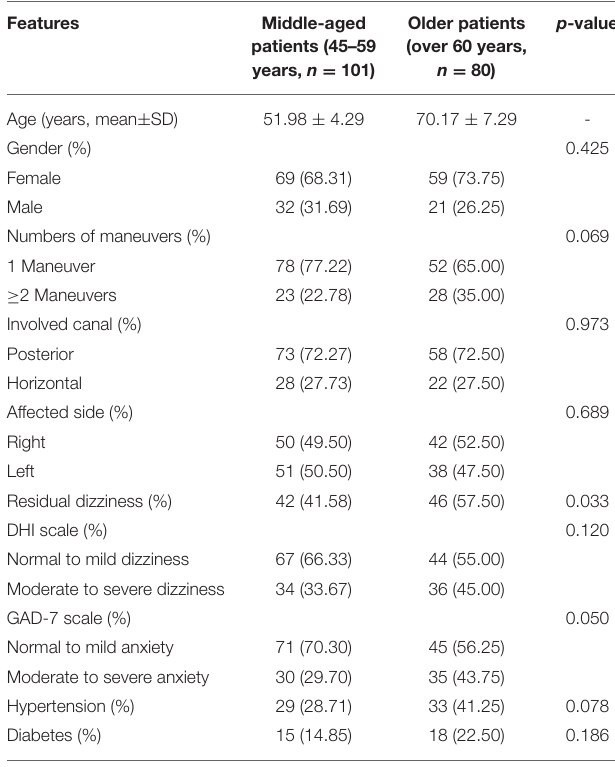
TABLE 1 | Clinical characteristics of middle-aged and older adults with